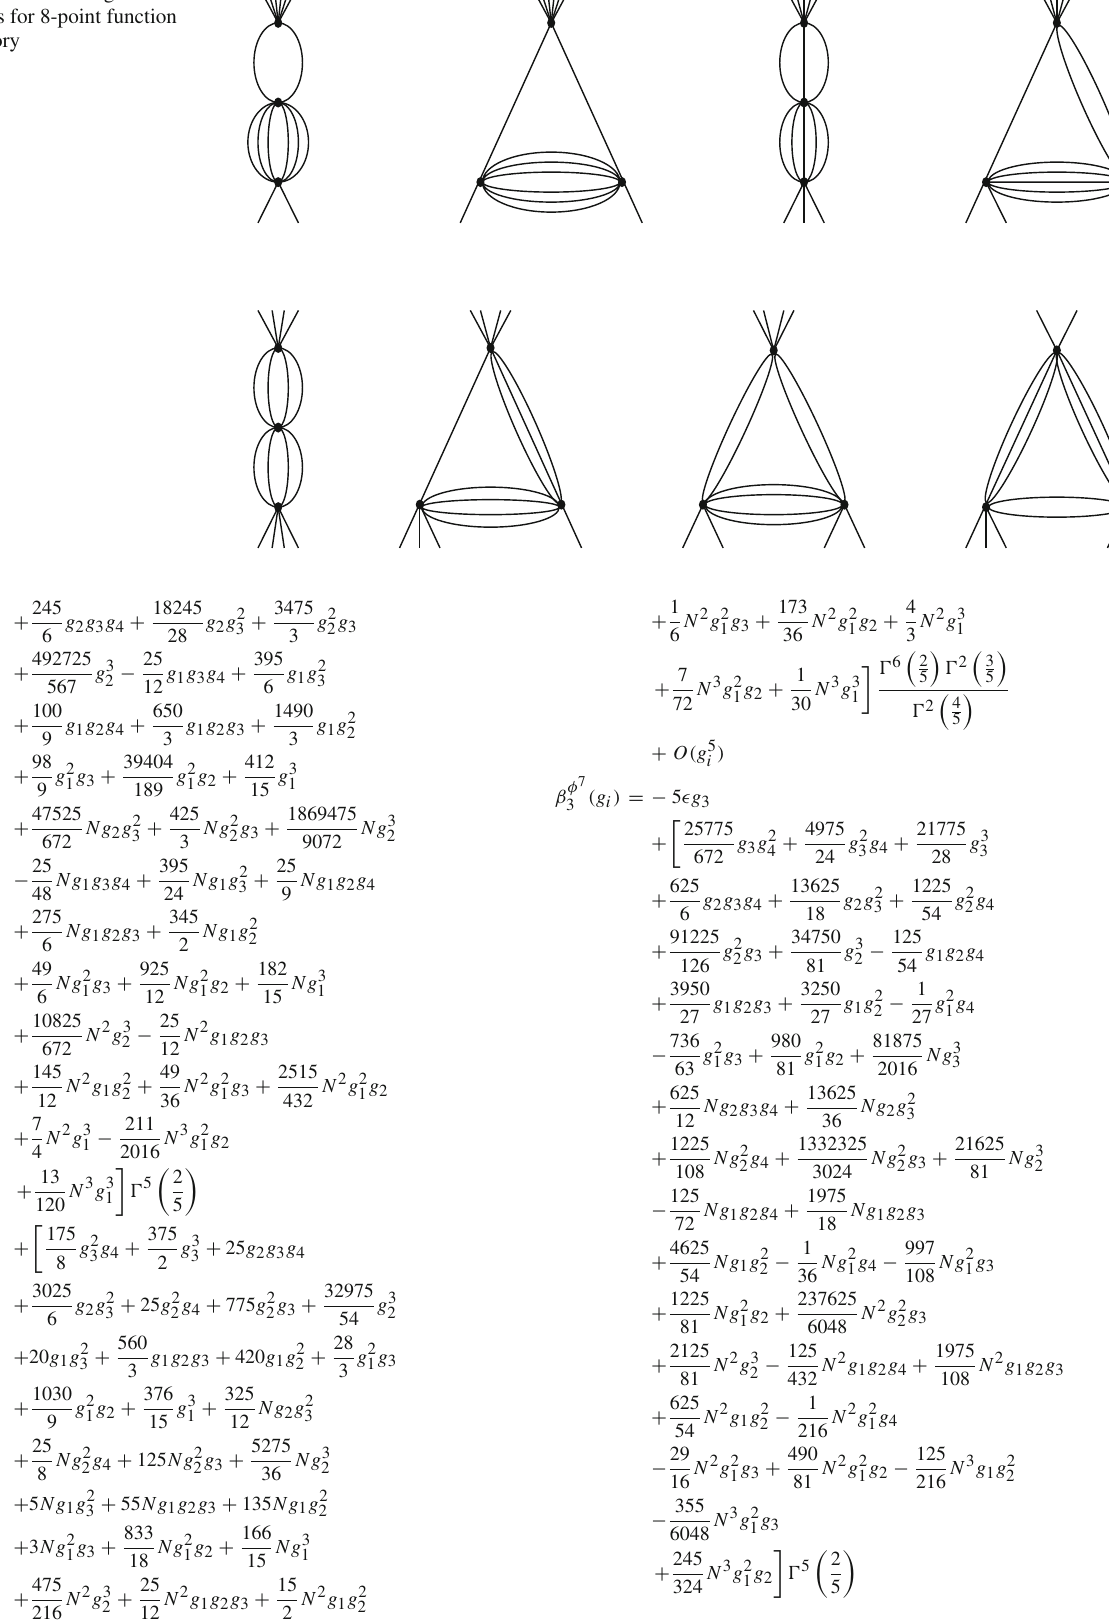
Fig. 8 Next to leading order topologies for 8-point function in φ 8